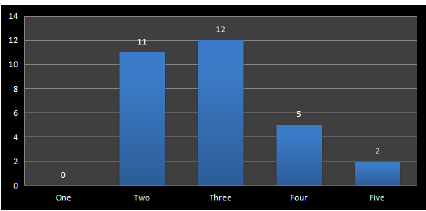
Figure 11. Distribution of study subjects according toclinical union time